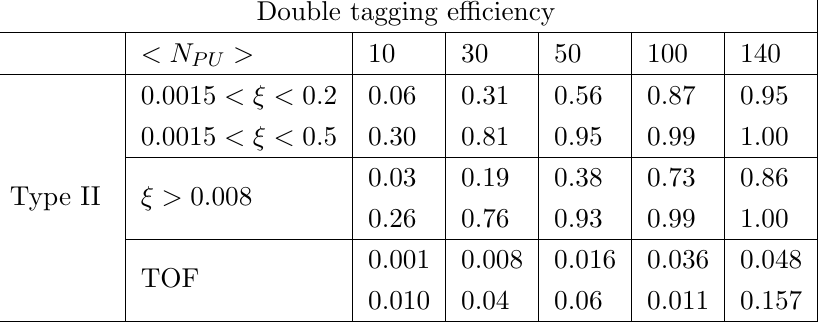
Table 1 . The fraction of remained events assuming the FDs acceptance, lower cut on the (cid:24) 1 ; 2 , and TOF requirement for di(cid:11)erent average numbers of pile-up are reported. At least one proton on each side of interaction point is required. The obtained fraction of events at each level includes all other previous cuts. The e(cid:14)ciency of double proton tagging is increased by rising the number of pile-up. accepted inclusive events that the time di(cid:11)erence of the arrival of their tagged protons